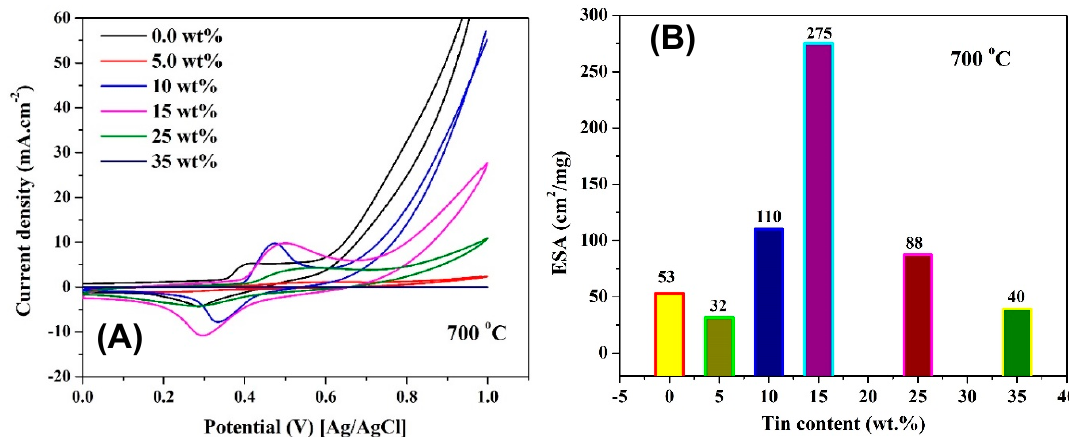
Figure 5. Activation of Sn-incorporated Ni/C nanofibers with different Sn contents and prepared at 700 °C ( A ); and influence of the Sn content on the electrochemical surface area ( B ).